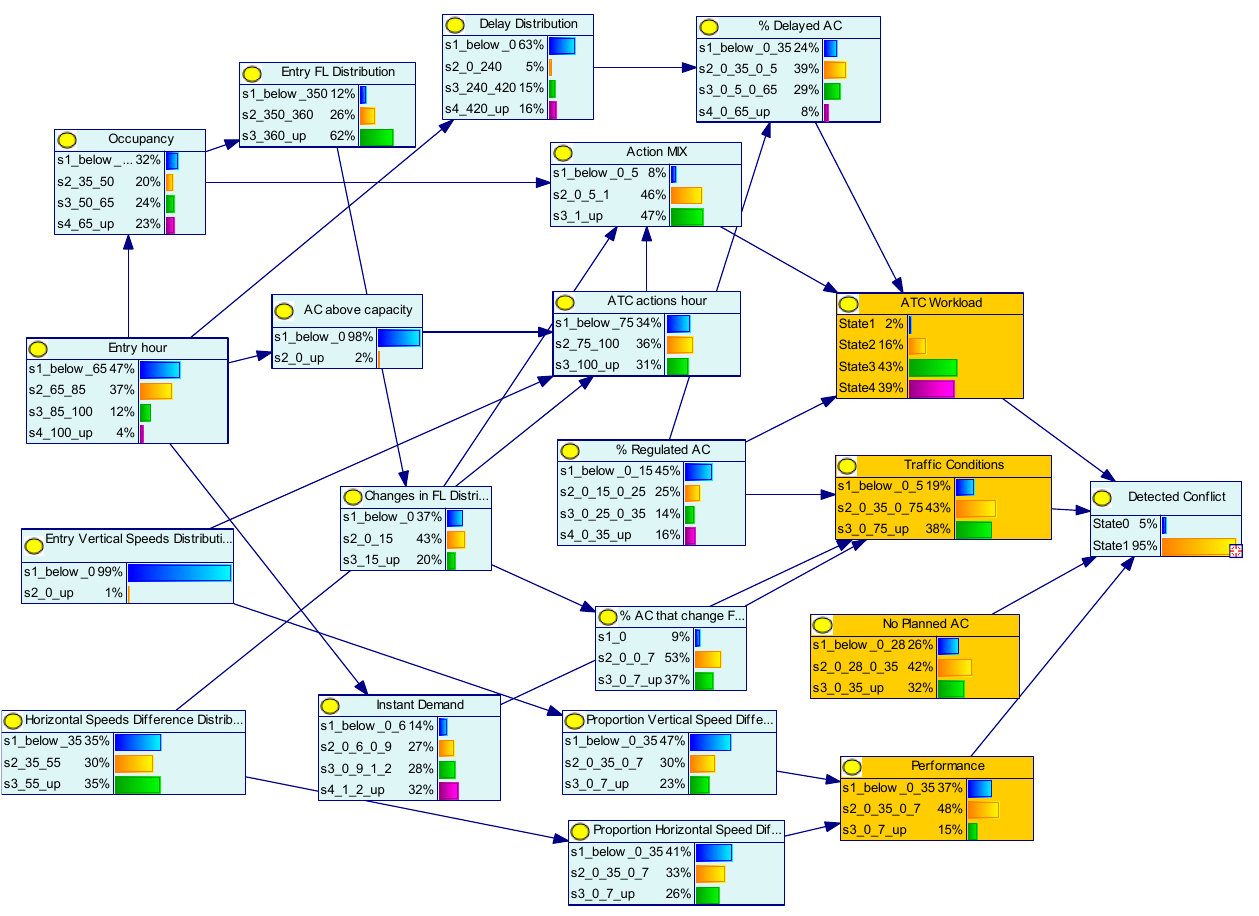
Figure 3. Probabilities directly observed from data, LECMSAN.